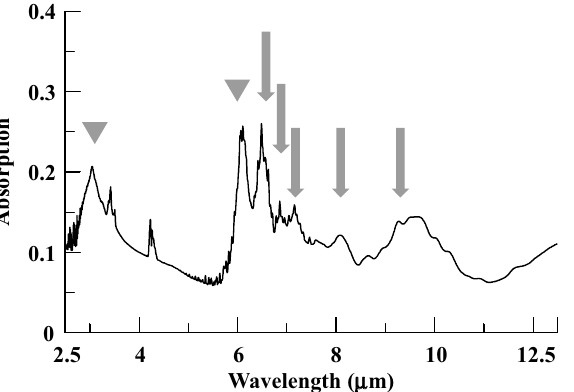
Figure 1. Measurement of the infrared absorption spectrum of E coli by infrared absorption spectroscopy. Several distinct absorption peaks are visible. A rather broad peak is seen at ~ 3.0 µm, narrow sharp and strong peaks are observed at 6.00 and 6.62 µm, weak peaks are present at 6.88 and 7.14 µm, and broad peaks can be seen at 8.09 and 9.26 µm. The peaks at around ~ 3.0 and 6.00 µm (marked by grey triangles) were